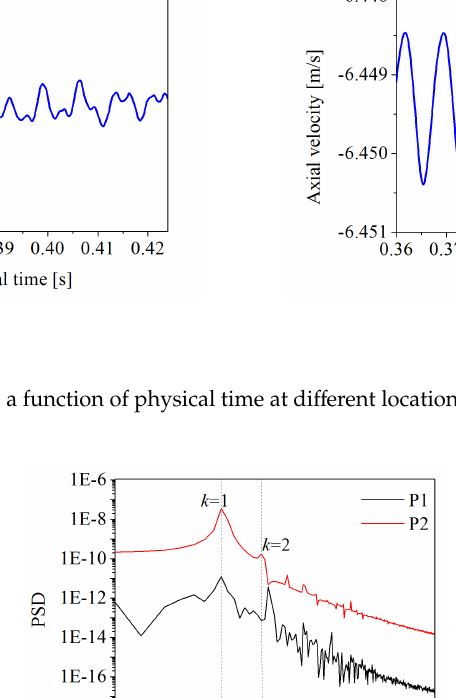
Figure 12. Power spectral density (PSD) of axial velocity at different locations.